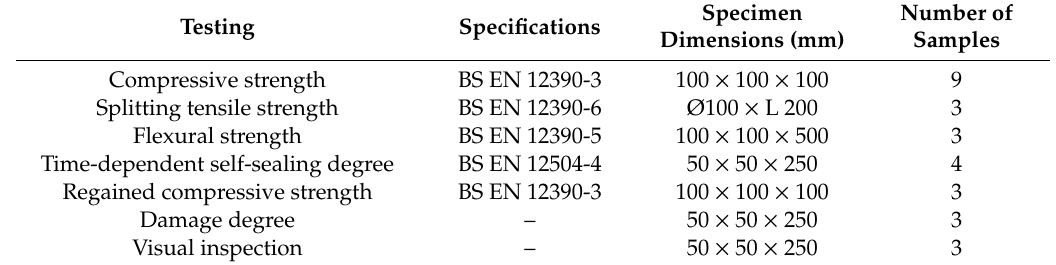
Table 4. Testing